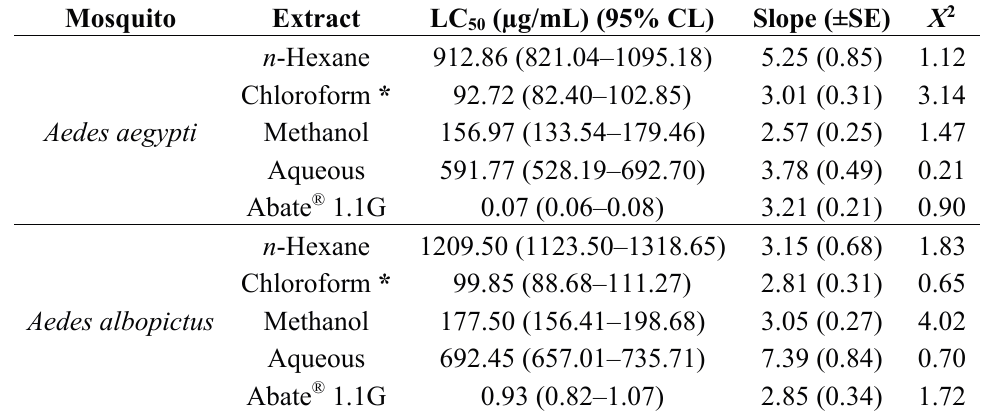
Table 2. Larvicidal activity of Bryopsis pennata extracts against Aedes aegypti and Aedes albopictus .